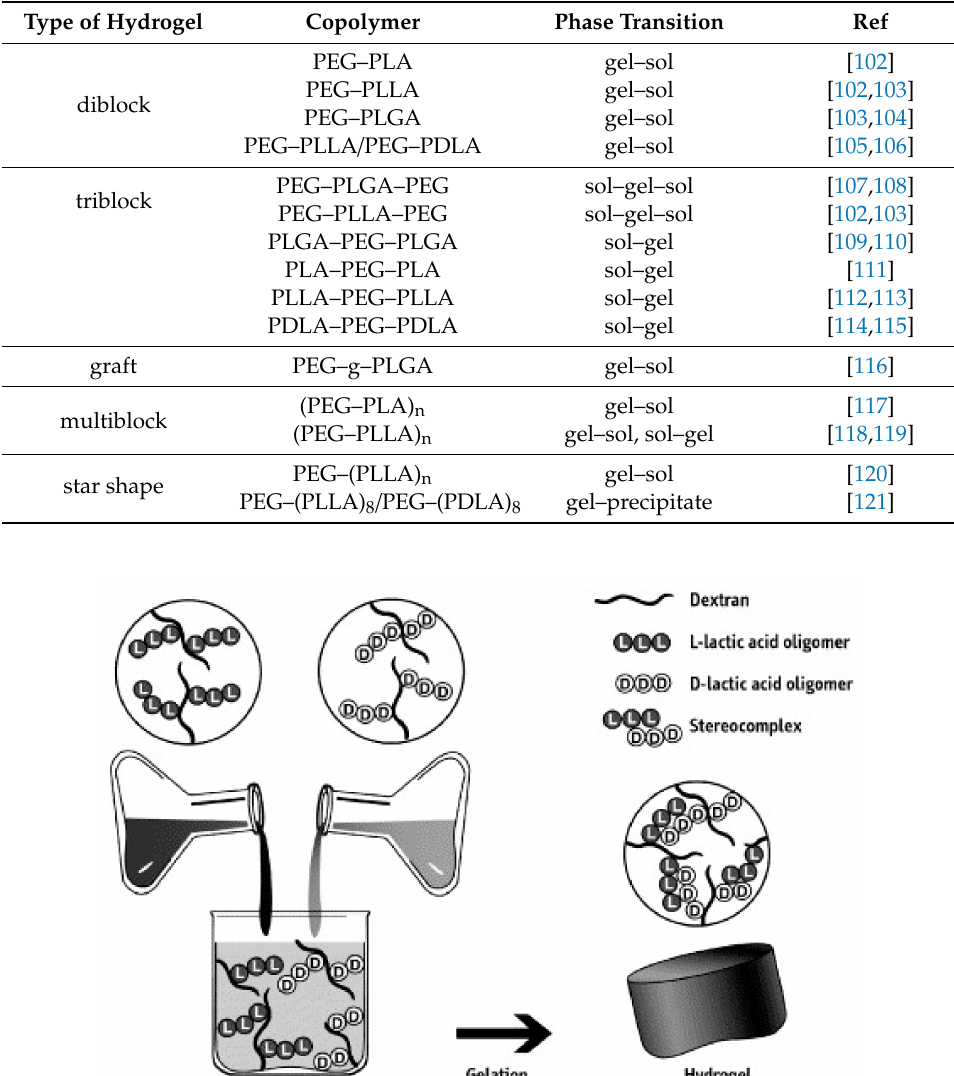
Table 1. Various types of thermo-induced physical hydrogel.